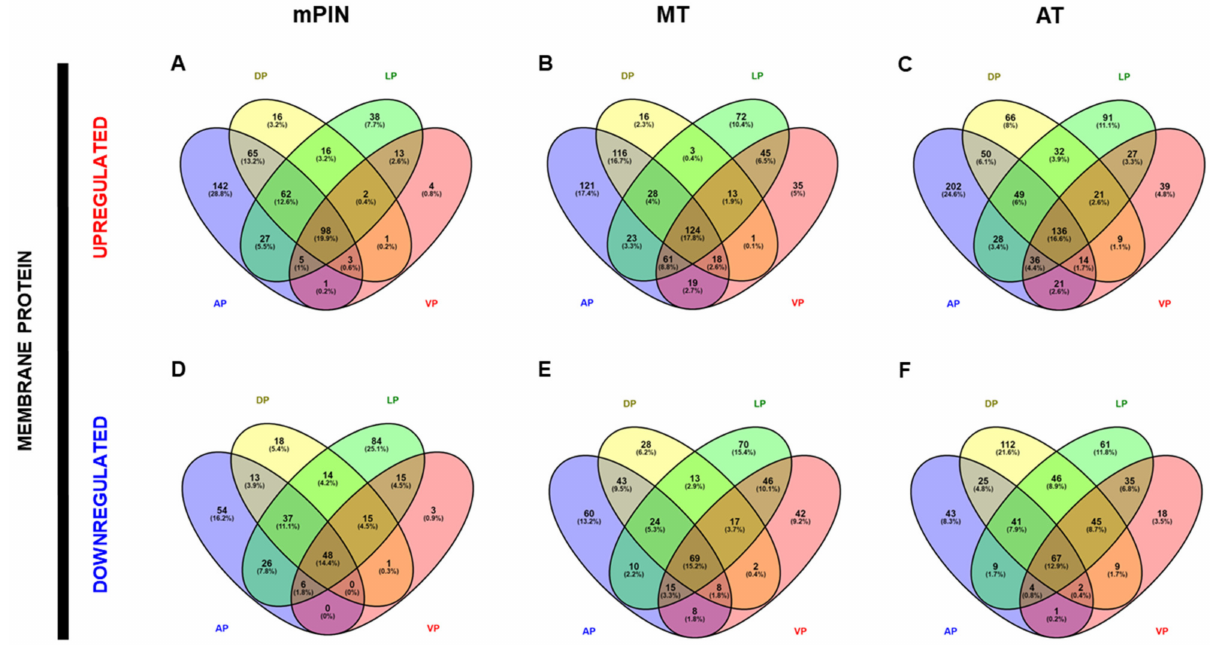
Figure 2. Venn’s diagrams depicting common genes of membrane proteins from Anterior Prostate (AP), Dorsal Prostate (DP), Lateral Prostate (LP), and Ventral Prostate (VP) PCa in Pten knockout mice. Venn’s diagrams of exclusive upregulated genes in mPIN ( A ), MT ( B ), and AT ( C ), and downregulated genes in mPIN ( D ), MT ( E ), and HT ( F ). mPIN = mouse Prostatic Intraepithelial Neoplasia. MT = Middle-stage tumor. AT = Advanced-stage